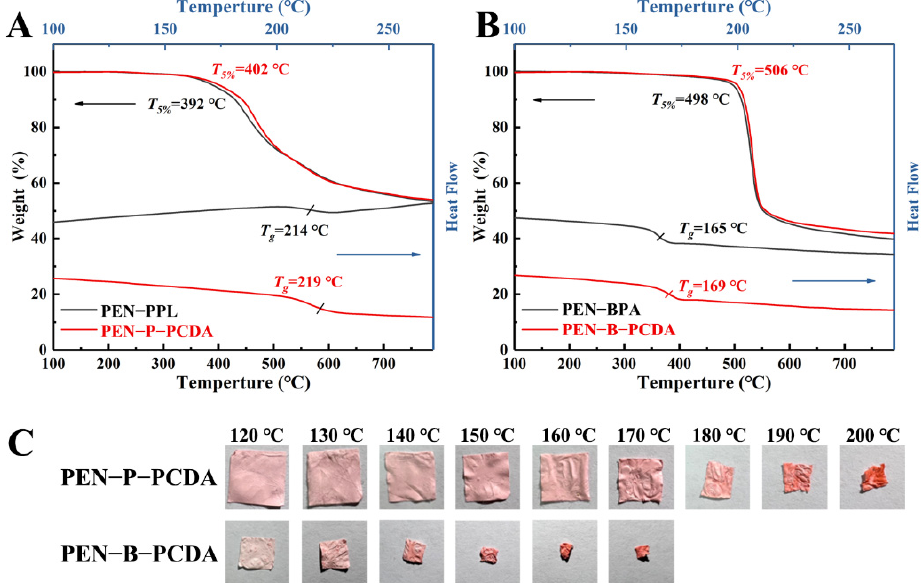
Figure 6. TGA and DSC curves of PEN − PPL and PEN − P − PCDA ( A ), PEN − BPA and PEN − B − PCDA ( B ), and the photographic images of nanofibrous membranes upon various high temperatures ( C ).